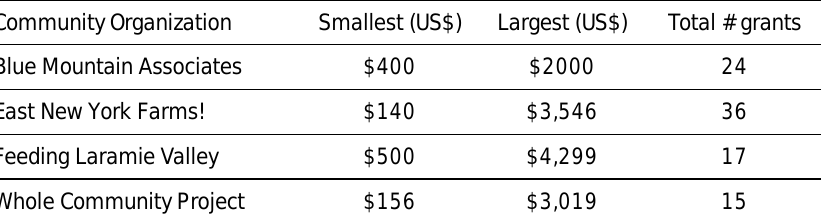
Table 2. Minigrant Counts and Size